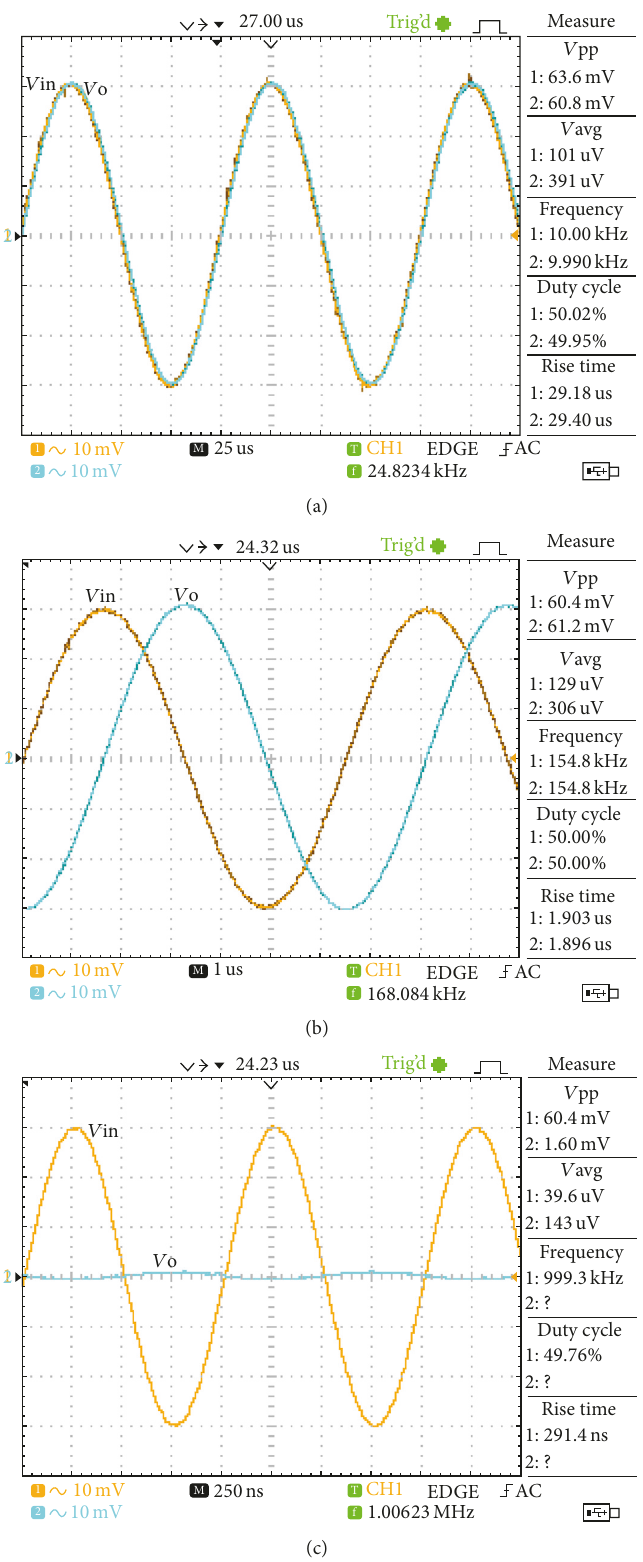
Figure 5: The measured input and output waveforms of low-pass filter at (a) 10kHz, (b) 155 kHz, and (c)